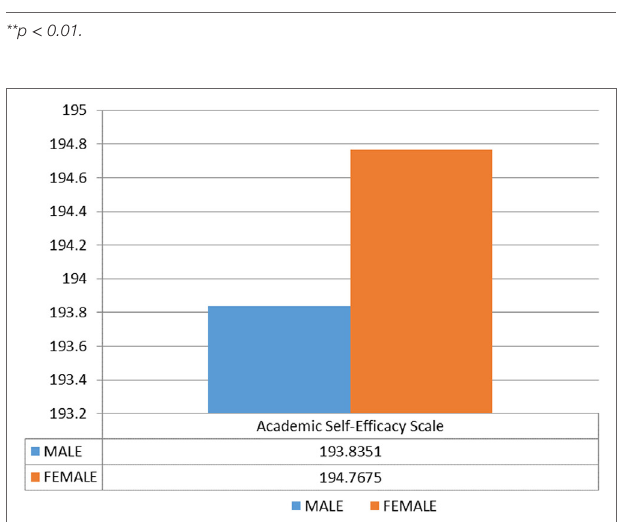
FigUre 1 | Male and Female Junior High Students’ Raw Score on Academic Self-efficacy Scale.